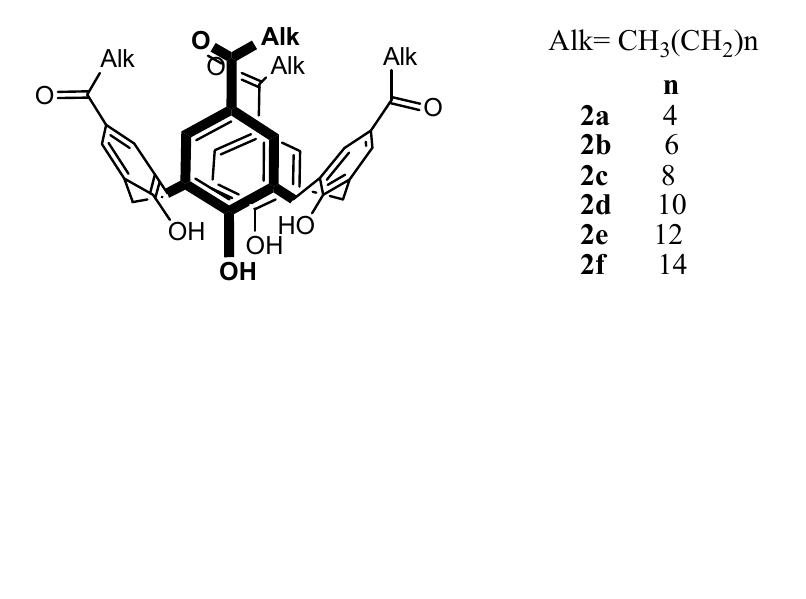
Figure 6. Chemical structures of amphiphilic